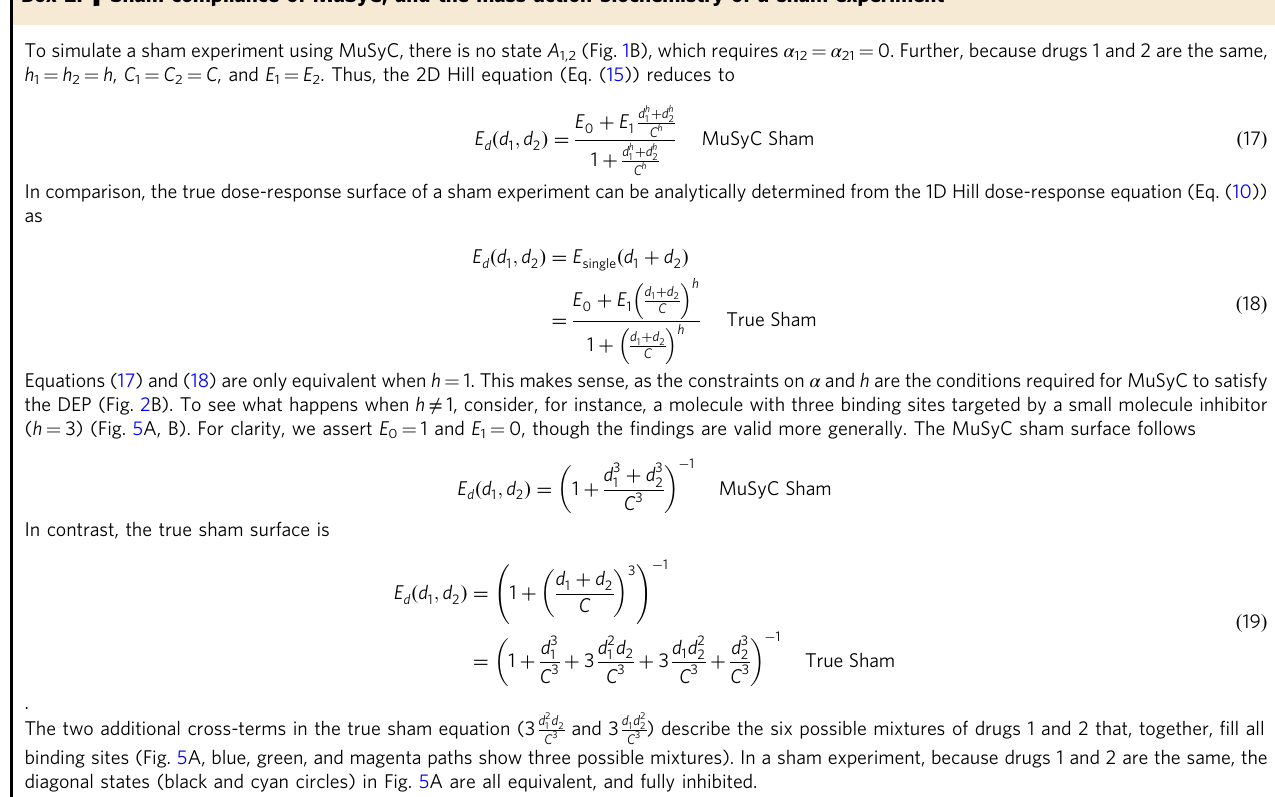
Box 2: | Sham compliance of MuSyC, and the mass action biochemistry of a sham